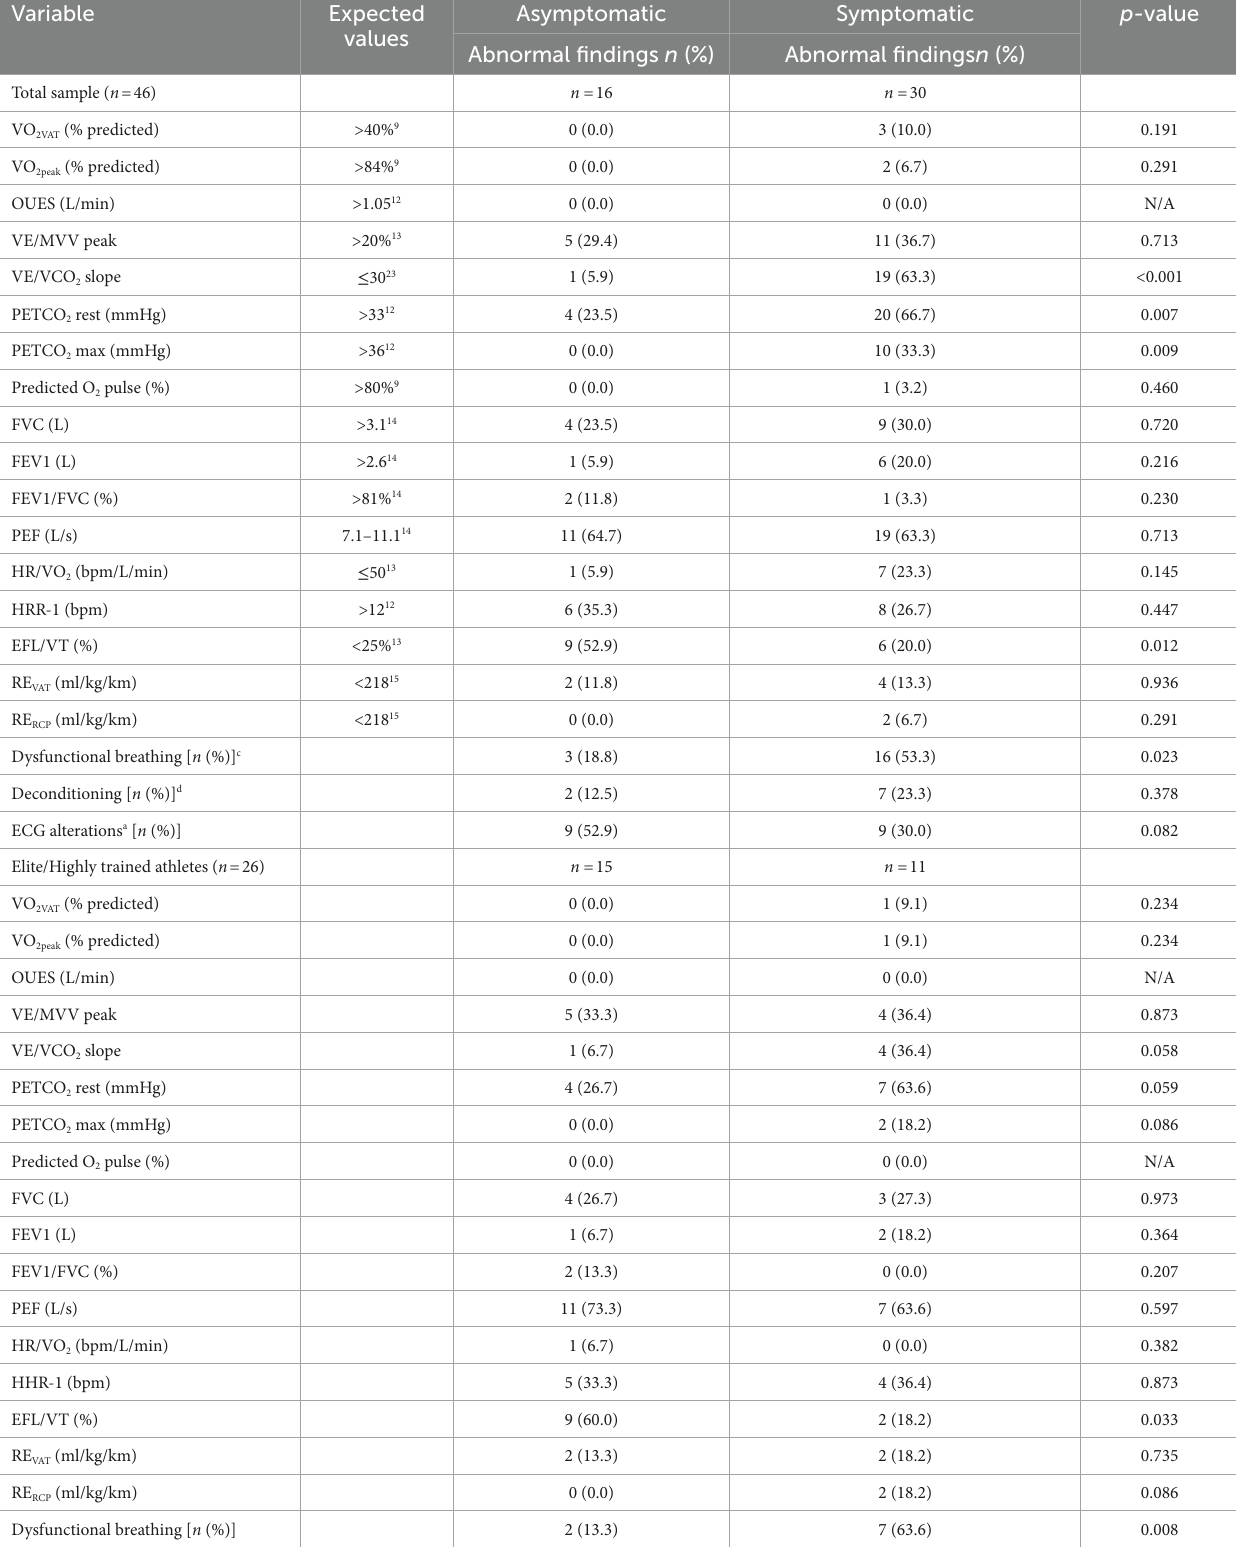
TABLE 3 Prevalence of abnormal findings on cardiopulmonary exercise test and spirometry variables according to the presence of persistent symptoms after COVID-19. Variable Expected Asymptomatic Symptomatic p- value values Abnormal findings n (%) Abnormal findings n